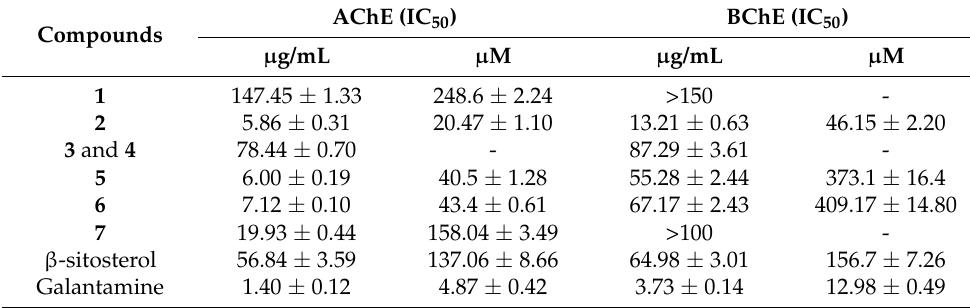
Table 4. The cholinesterase inhibitory potentials of the isolated